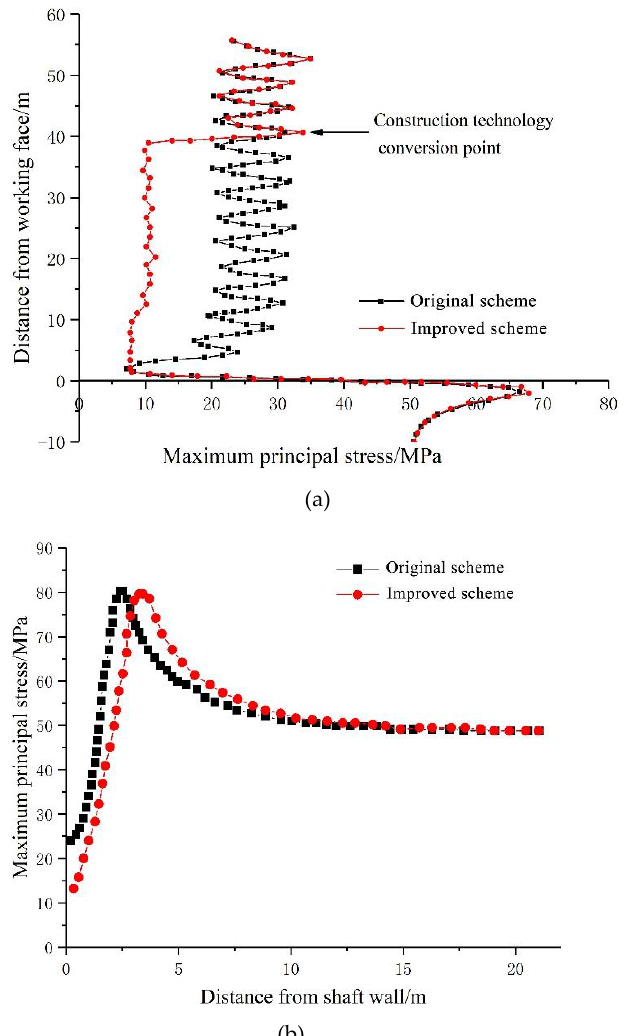
Figure 13. Major principal stress contrast of shaft. ( a ) Vertical section of the shaft. ( b ) Cross section of the shaft.